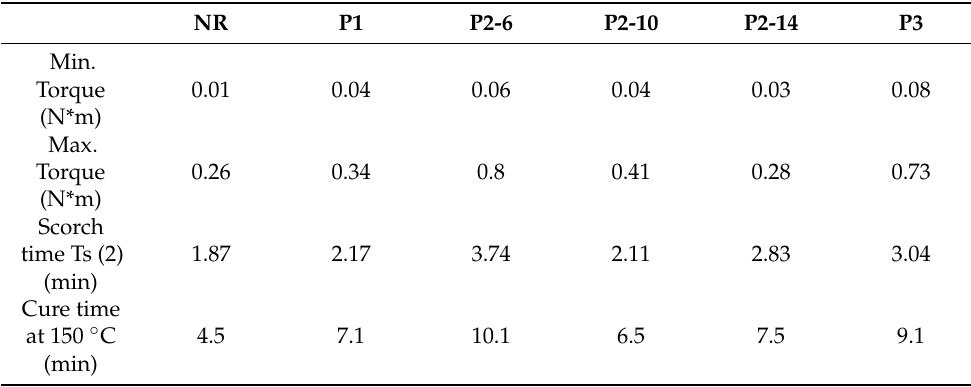
Figure 2. Aspect of the compound before curing. Table 2. Curing characteristics for the different composites.